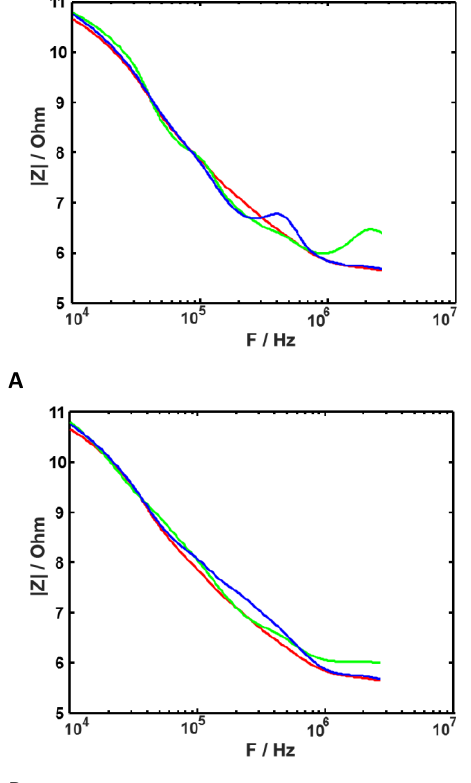
Fig. 8: Local signal approximations for spheroid in nozzle. A : without correction. B : with